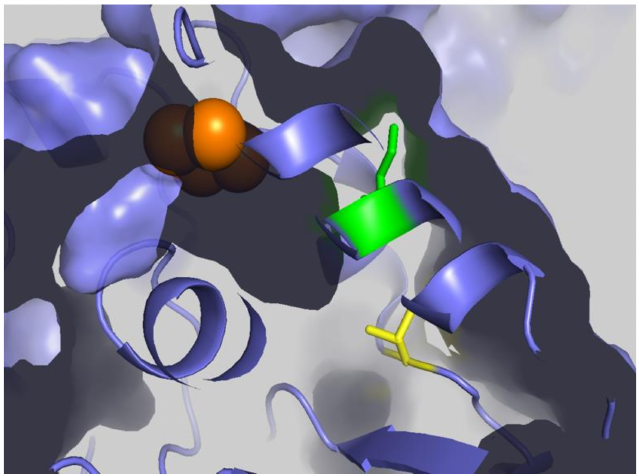
Figure 11. FECH Cluster tunnel. Surface representation of FECH with [2Fe-2S] clusters shown as orange spheres, K415 shown as green, and C395 shown as yellow sticks. Figure created using PyMol (Schrödinger, Inc., New York, NY, USA) and PDB ID